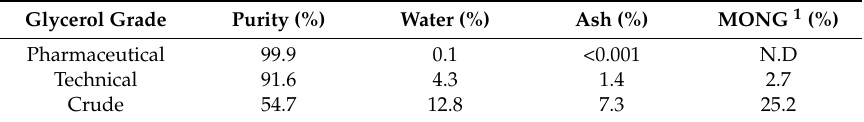
Table 3. Composition of different grades of glycerol.